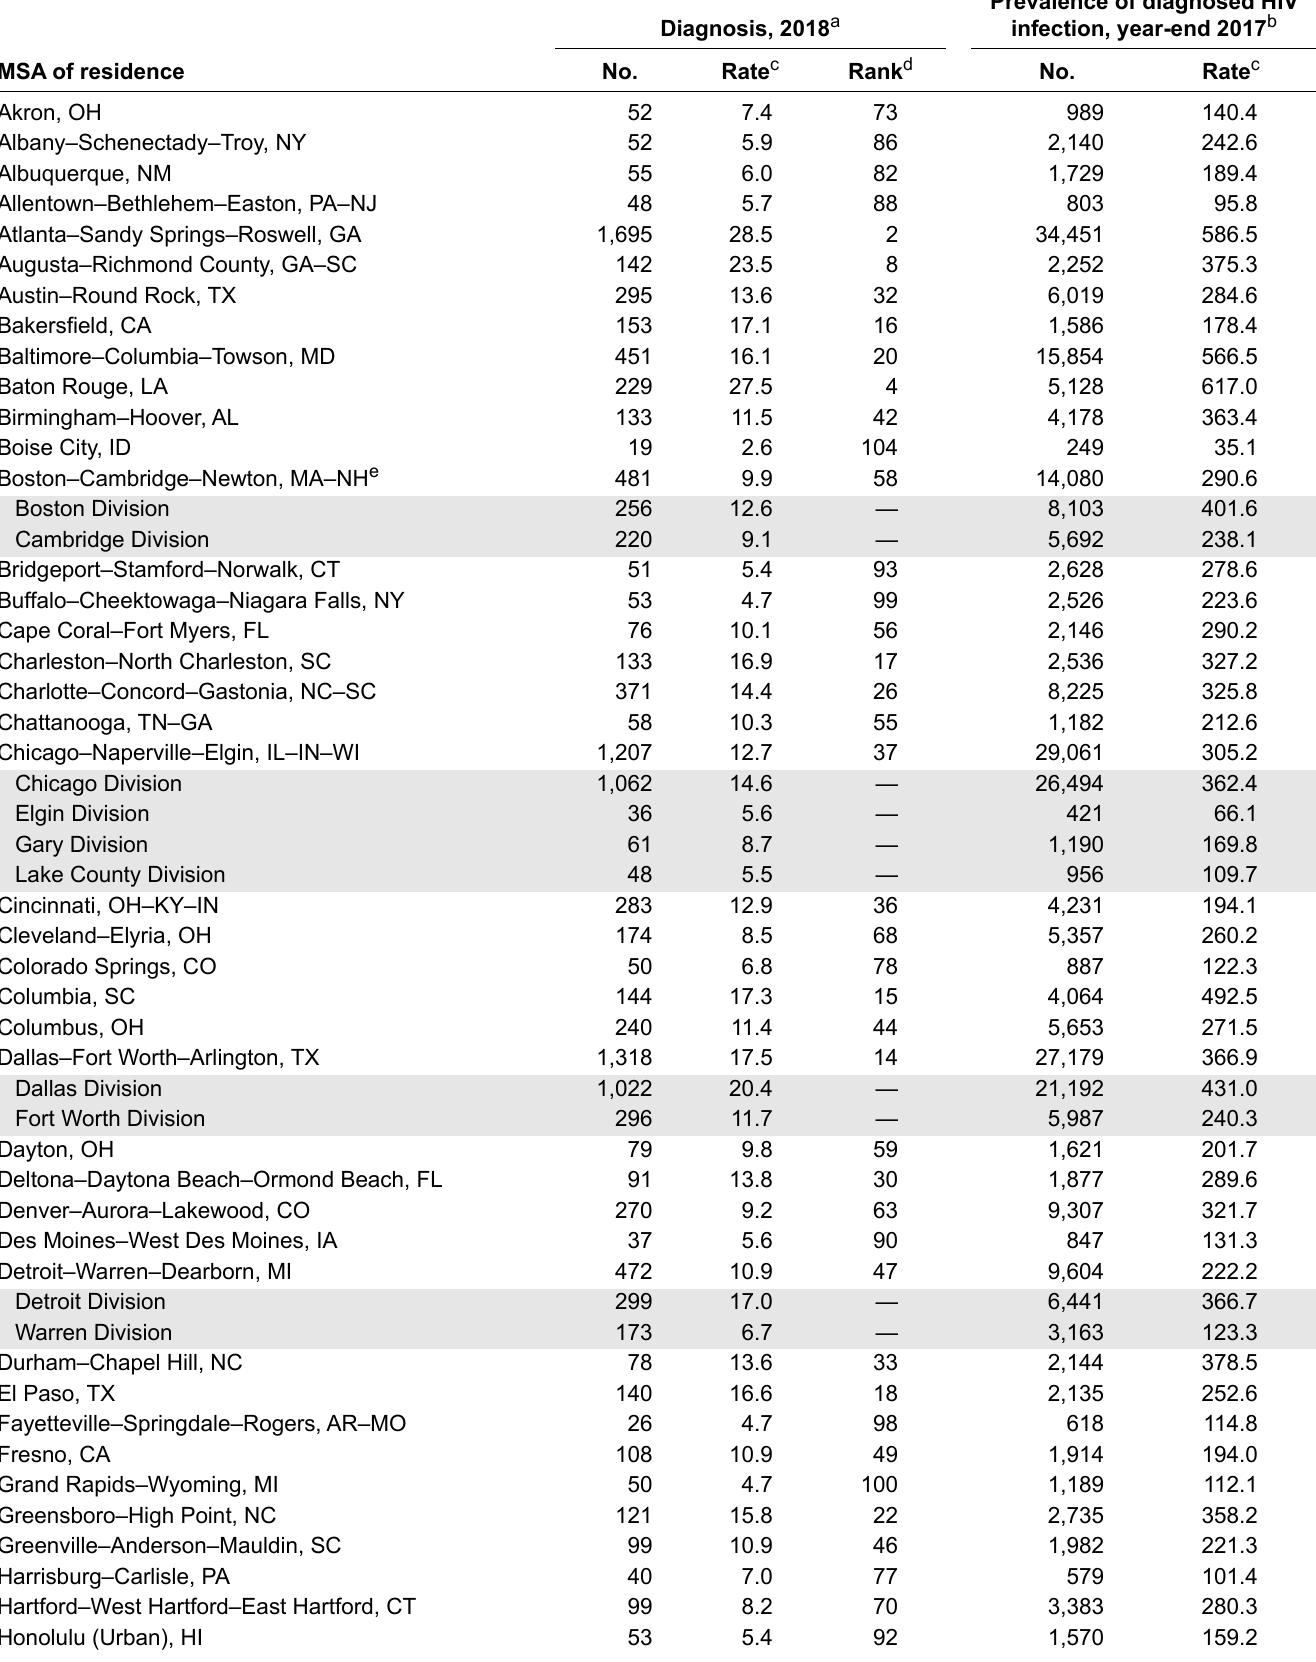
Table 30. Diagnoses of HIV infection, 2018, and persons living with diagnosed HIV infection (prevalence), year- end 2017, by metropolitan statistical area of residence—United States and Puerto